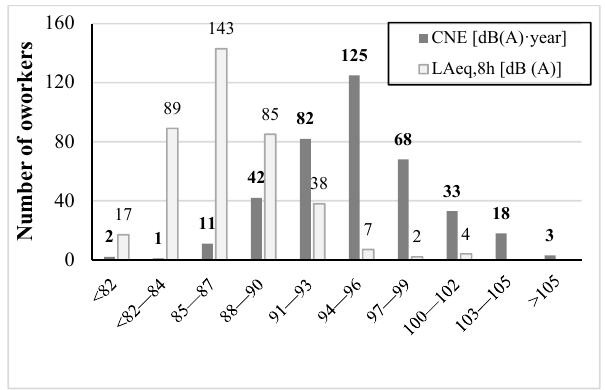
Figure 1. Noise exposure level (L Aeq,8h ) and cumulative noise exposure (CNE) distribution of the noise-exposed workers. The mean L Aeq,8h was 87 dB (A), ranging from 78 to 102 dB (A); CNE ranged from 80 to 111 dB (A)·year with a median level of 95 dB (A)·year.